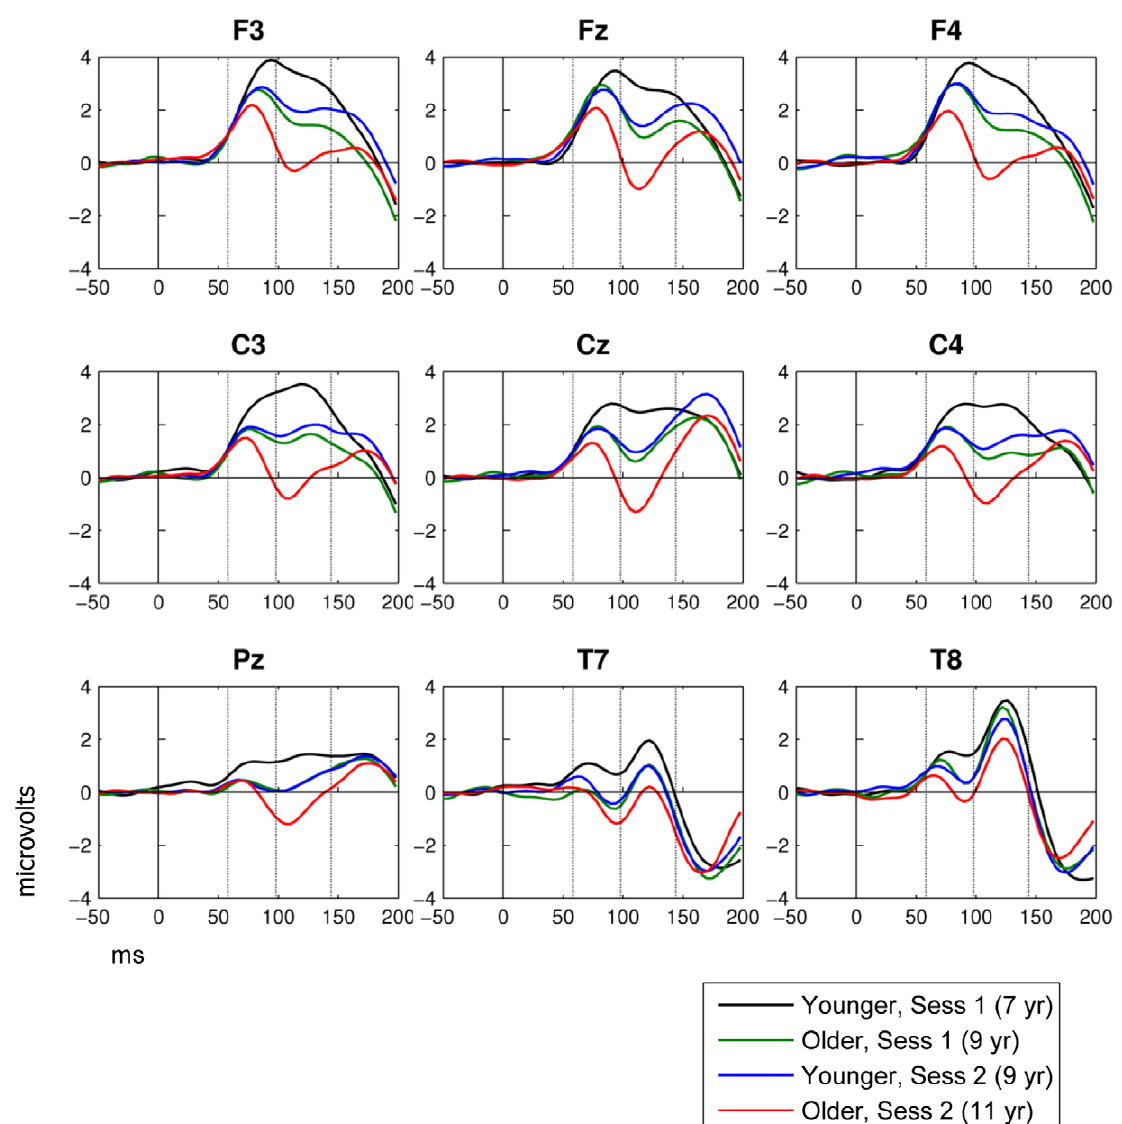
Figure 1. Mean ERP amplitude ( m v) by time (ms) at nine sites in relation to group and session. ANOVA confirmed that, in the two windows of interest (demarcated by vertical gray lines), there were substantial age effects on mean amplitudes, as well as significant interactions between age and electrode (see text).